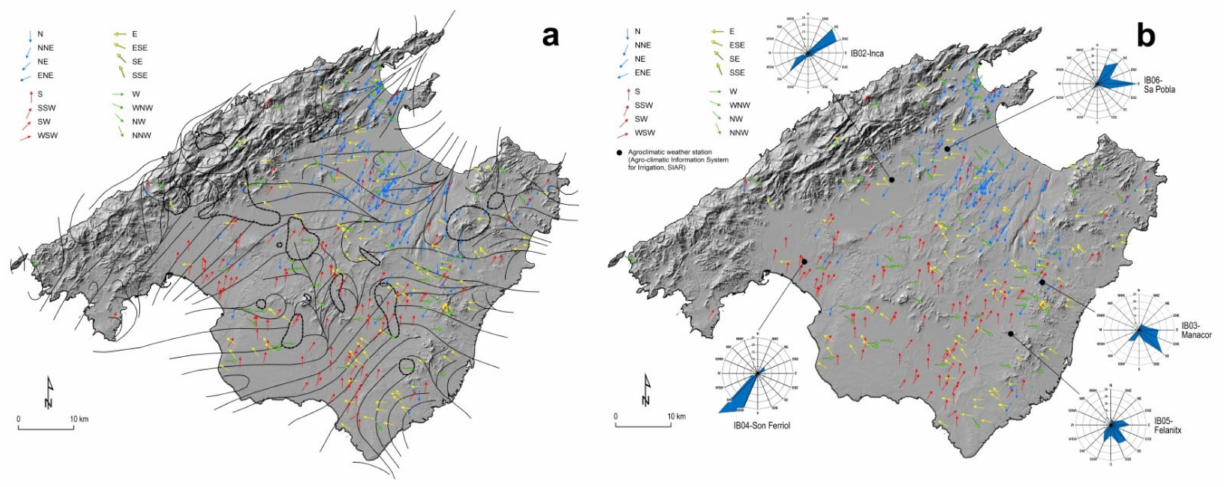
Figure 14. On the left ( a ), comparison of the ‘anemographic’ model with Chart I (Current lines) and Chart II (Convergence zones) of the sea-breeze regime in Mallorca [34]; On the right ( b ), comparison of the ‘anemographic’ model with the relative frequency distribution (%) of the wind direction (polar bar chart) at the time of theoretical maximum sea-breeze intensity (13 UTC), for five meteorological stations of the Sistema de Informaci ó n Agroclim á tica para el Regad í o (SIAR), Spain (17-year study period,